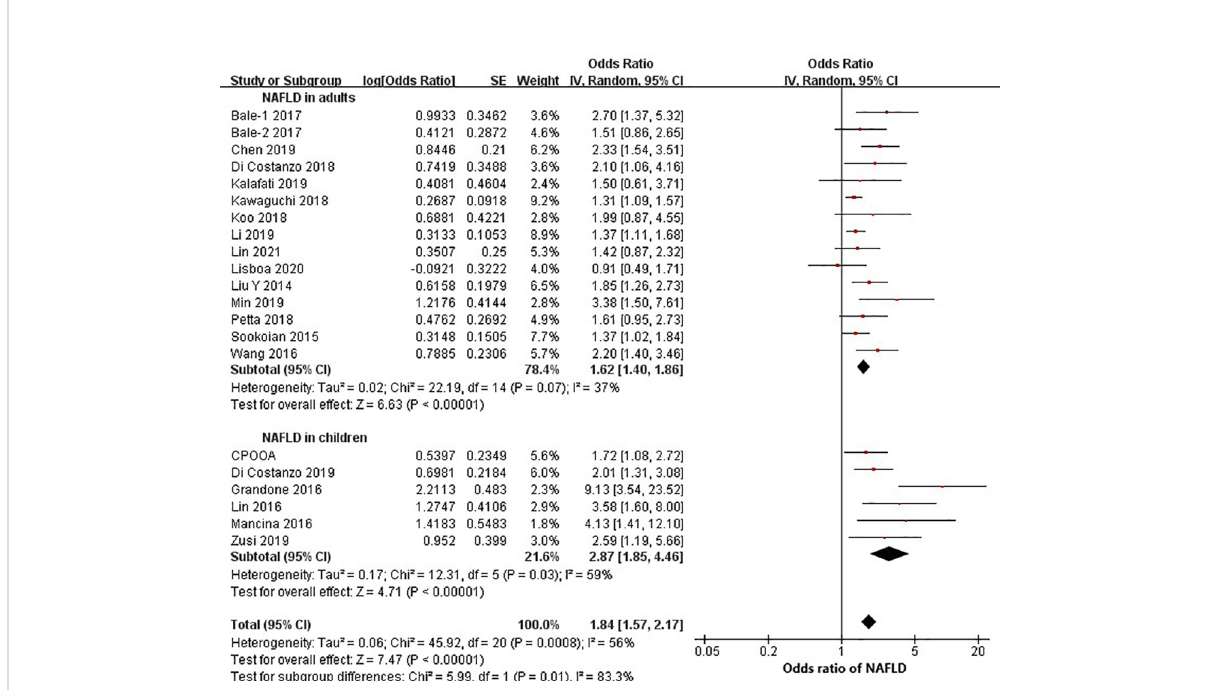
FIGURE 2 rs58542926 T allele was associated with a higher odds ratio of NAFLD. Data from 19,445 individuals (15,901 adults, 3544 children) with CT, MRI or FibroScan. rs58542926 T allele was positively associated with NAFLD in both adults and children (using a dominant model of inheritance). Meta-analysis was performed using random effects with the DerSimonian − Laird method for estimation of tau2; NAFLD, nonalcoholic fatty liver disease; CI, con fi dence interval; SE, standard error.